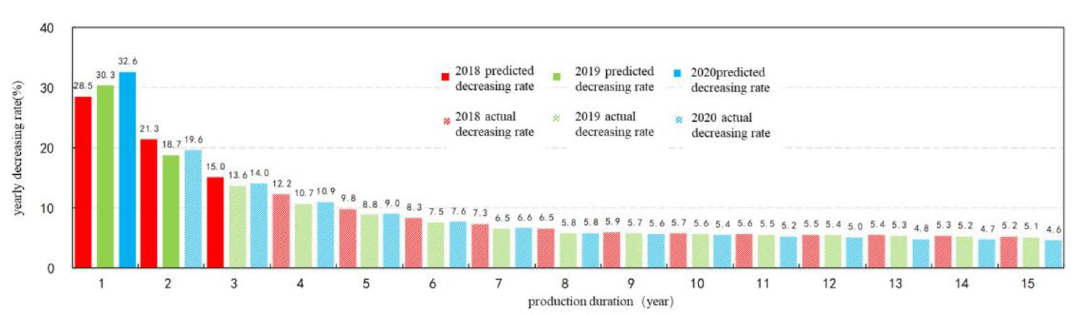
Figure 12. Yearly production decrease shale oil horizontal wells in Ordos